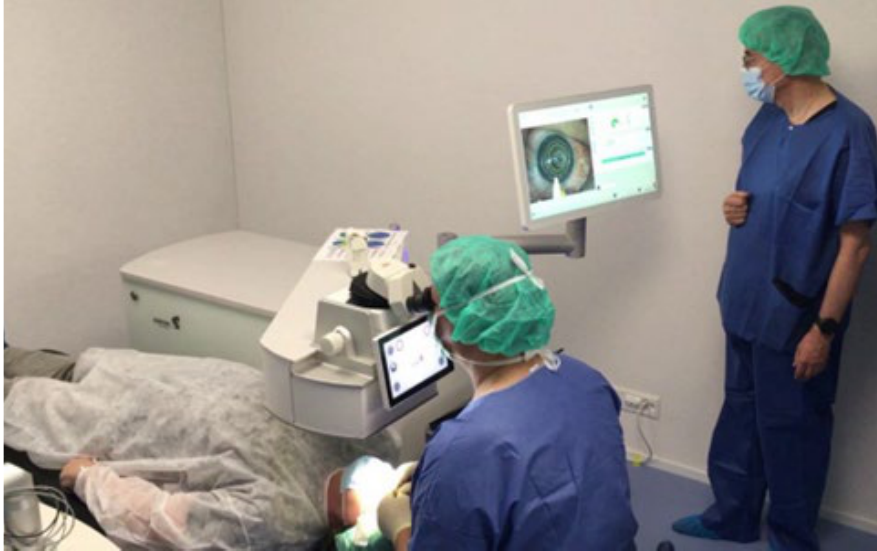
Figure 2. Footage of the AquariuZ in a clinical setting during a refractive procedure.